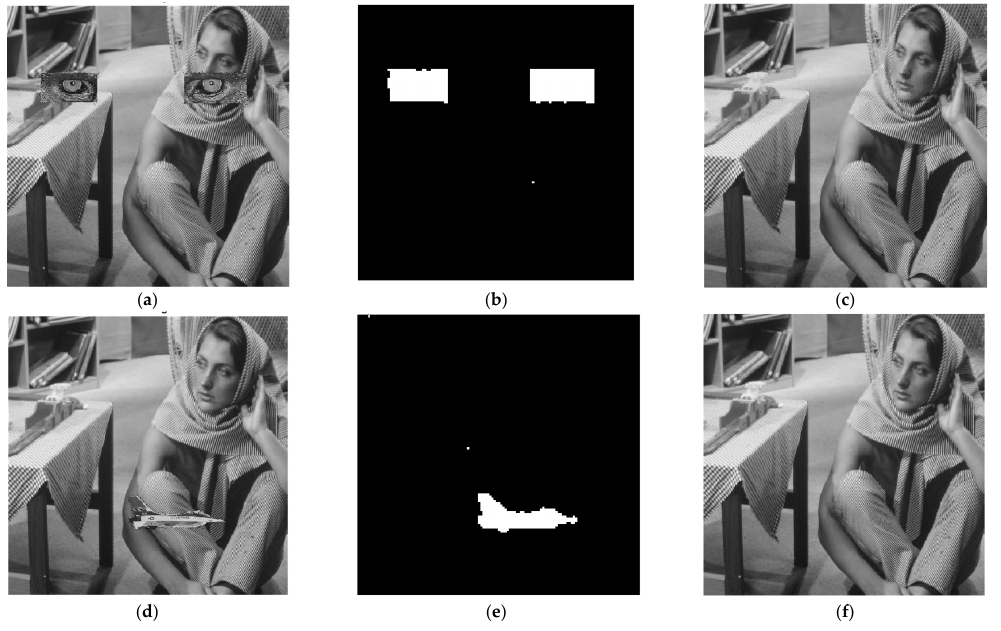
Figure 13. The visual performance for Airplane: ( a ) Copy-paste attack 1, ( b ) Detection of ( a ), ( c ) Recovery of ( a ), ( d ) Copy-paste attack 2, ( e ) Detection of ( d ), and ( f ) Recovery of ( d ).